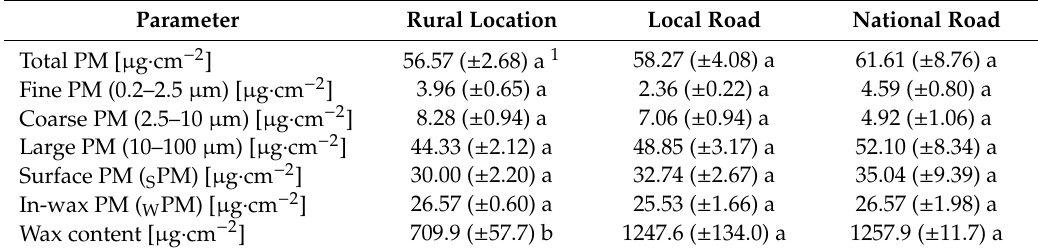
Table 9. E ff ect of orchard location proximity to roads with di ff erent tra ffi c intensity) on accumulation of total PM (0.2–100 µ m), fine PM (0.2–2.5 µ m), coarse PM (2.5–10 µ m), large PM (10–100 µ m), surface PM ( S PM), in-wax PM ( W PM), and wax content on plum fruits. Data are means ± SE, n = 3.